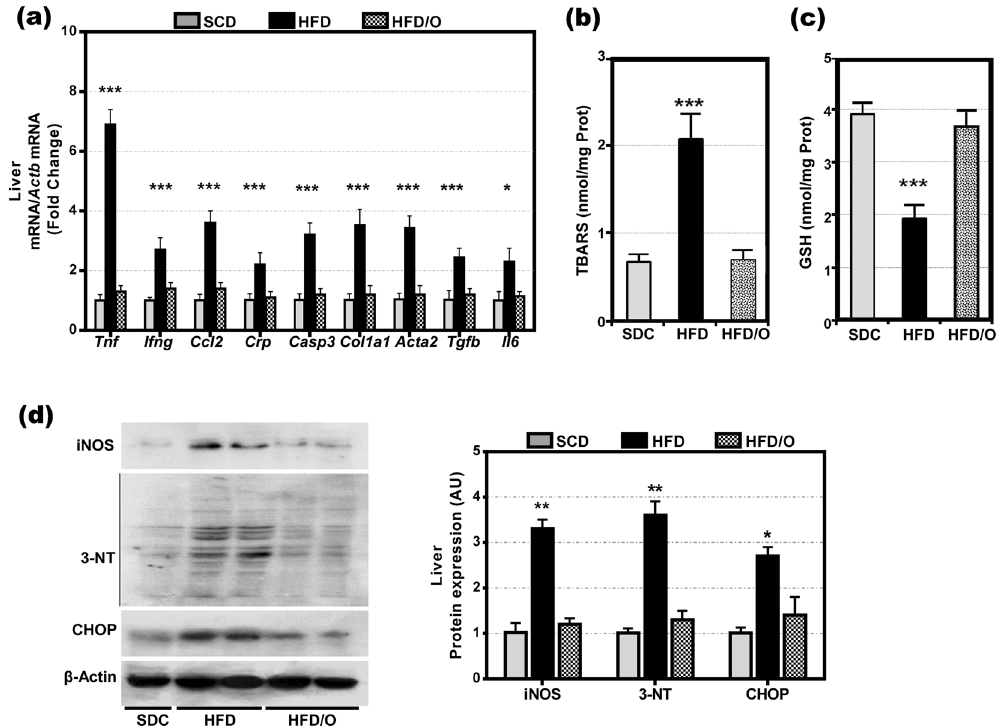
Figure 4. Effects of a HFD and omentectomy on hepatic gene expression of Tnf, Ifng, Ccl2, Crp, Casp3, Col1a1, Acta2, Tgfb and Il6 , on hepatic TBARS and reduced glutathione levels, and on hepatic protein expression of 3-tyrosine nitrate protein, and CHOP. ( a ) Gene expression of Tnf, Ifng, Ccl2, Crp, Casp3, Col1a1, Acta2, Tgfb and Il6 . ( b ) Hepatic concentration of TBARS. ( c ) Hepatic concentration of reduced glutathione. ( d ) Protein expression of iNOS, 3-tyrosine nitrated proteins (3-NT), CHOP, and β -actin. Bar graph illustrating the protein expression is shown. Data are mean ± S.D., * p < 0.05; ** p < 0.01 *** p < 0.001 vs .